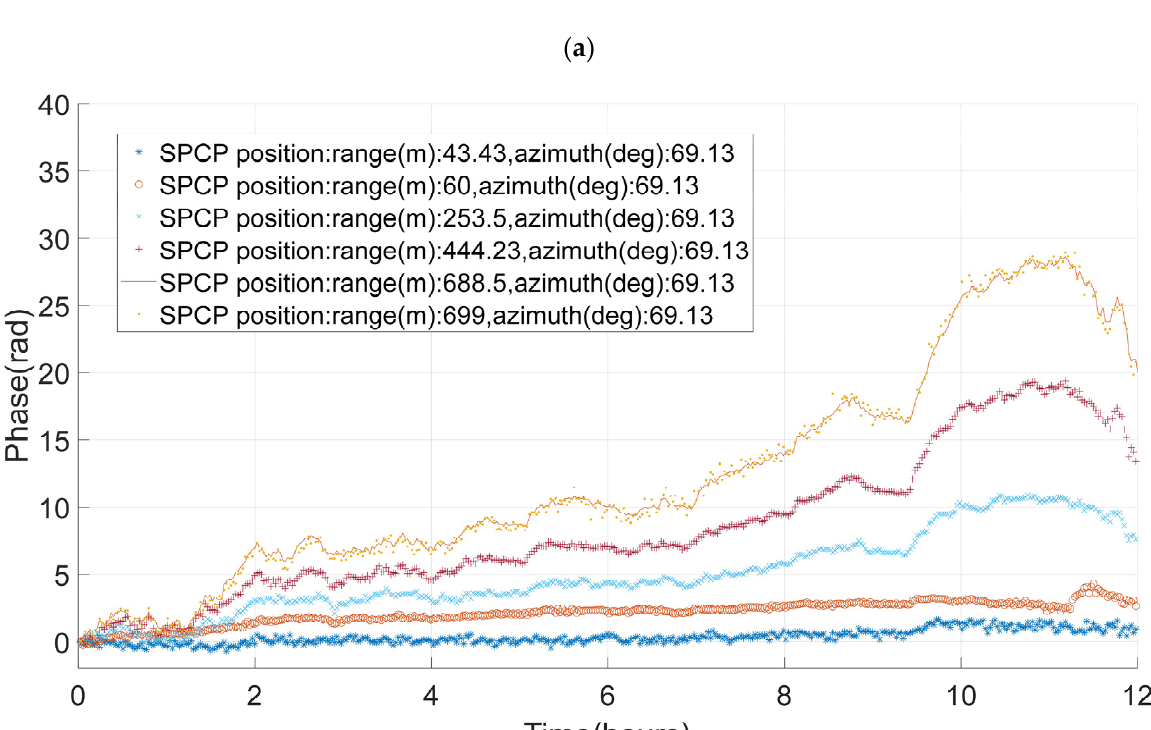
Figure 10. The phase change history of SPCPs: ( a ) with the same range and different azimuths; ( b )